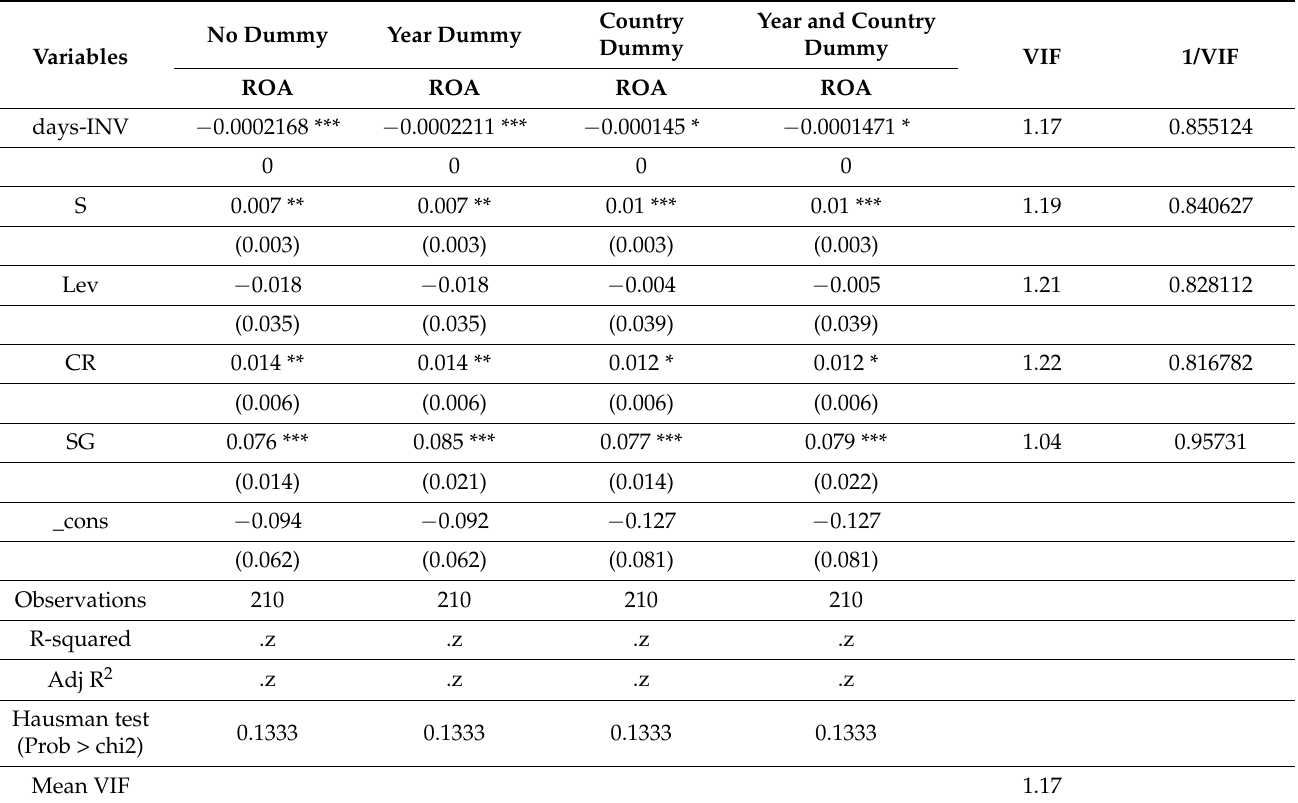
Table 9. Results of the random effects of days-INV on ROA, as per panel regression (pandemic period,